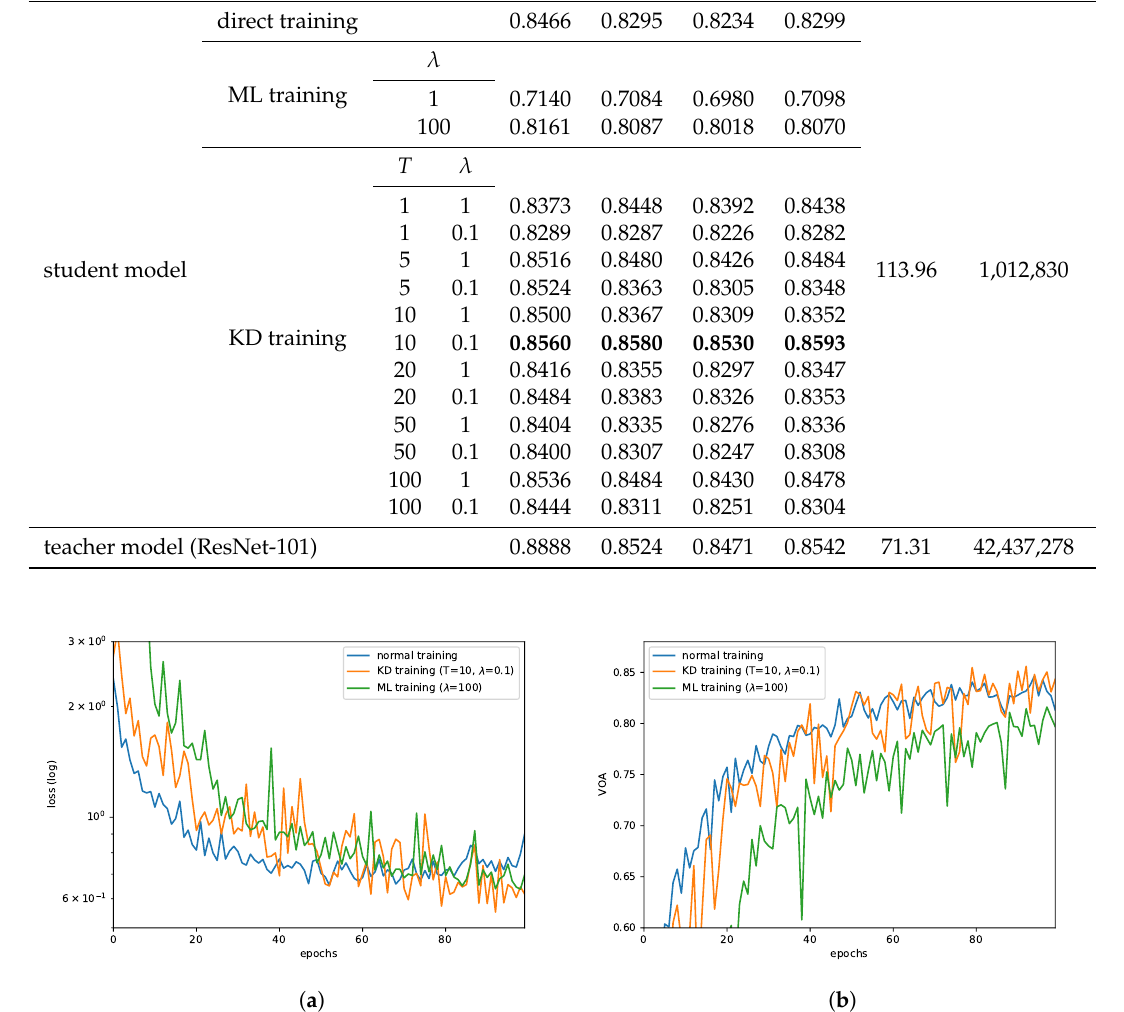
Figure 4. The training curves of the student model in AID experiments. From training curves, we could find that direct training (blue curves) leads to faster convergence but falls into local optima after 50 epochs, while KD training (orange curves) could always reduce the loss. ( a ) validation loss curve in logarithmic coordinate system; ( b ) validation OA